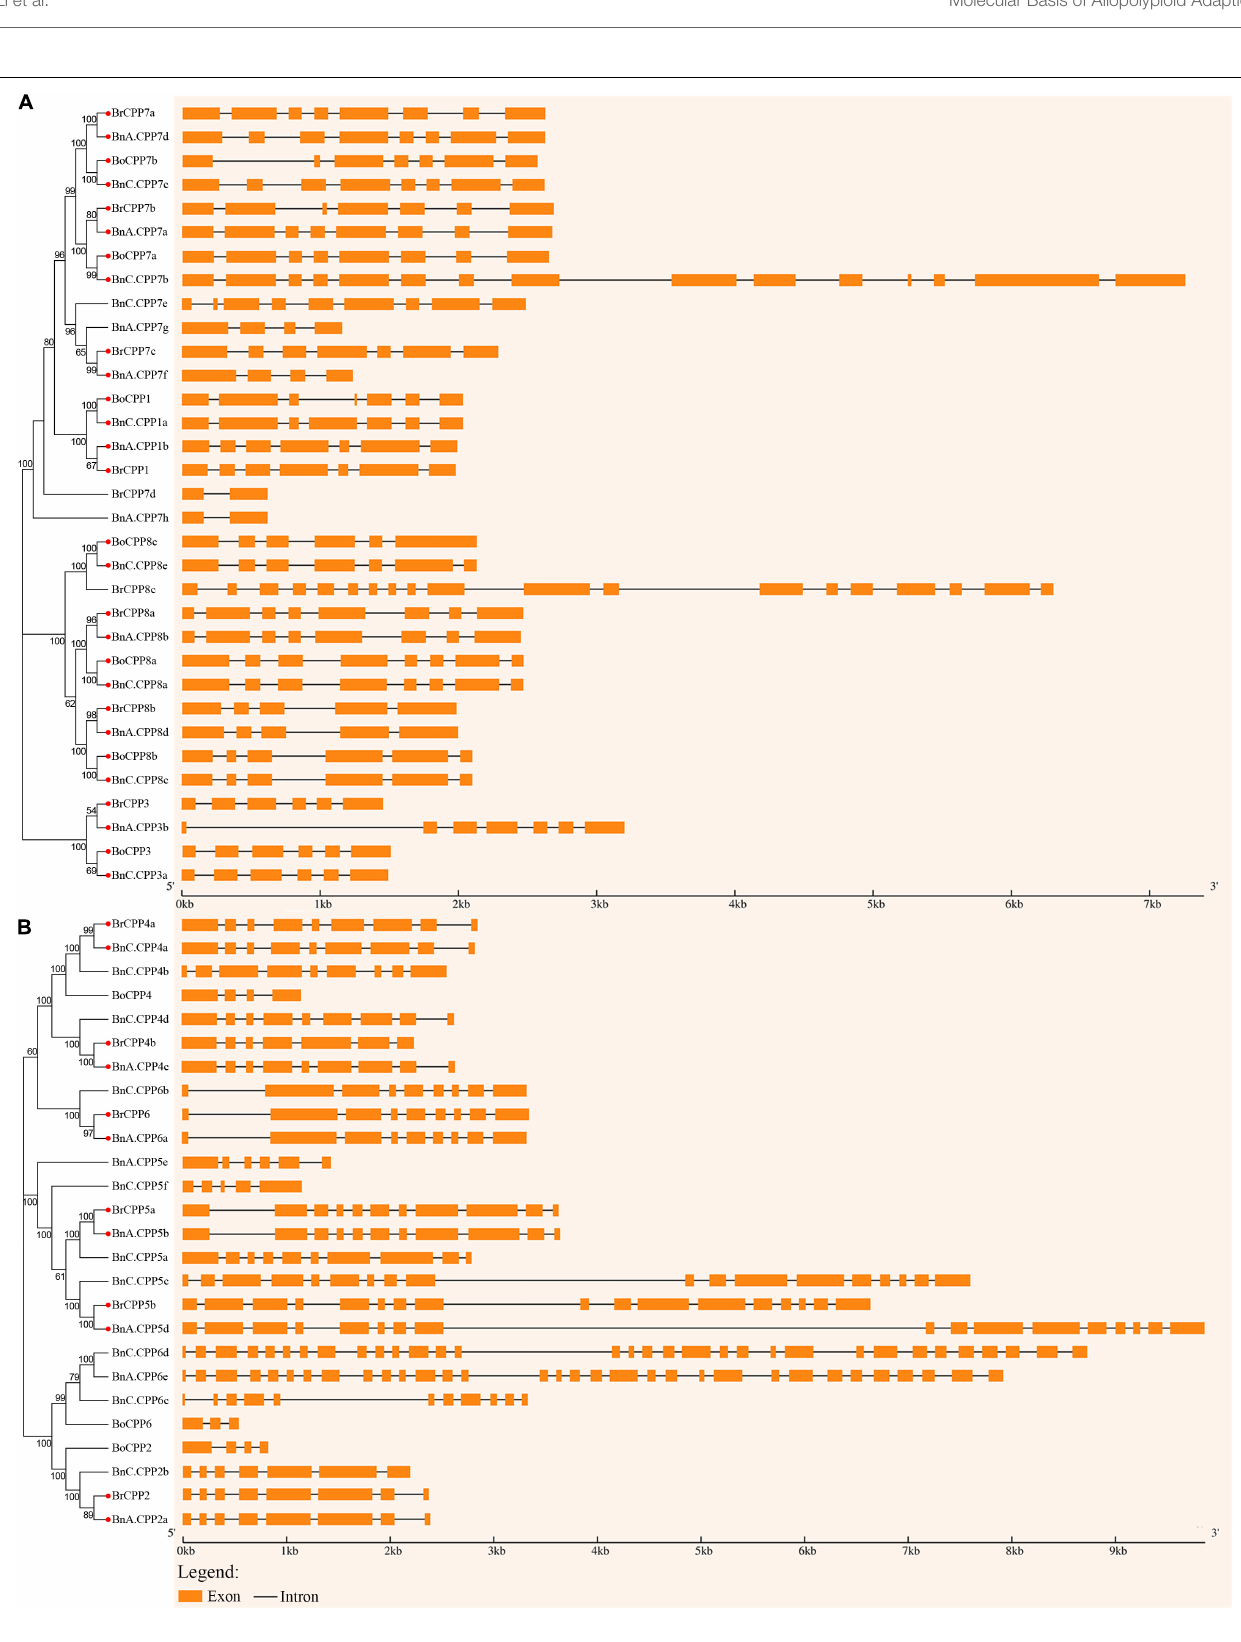
Frontiers in Plant Science |